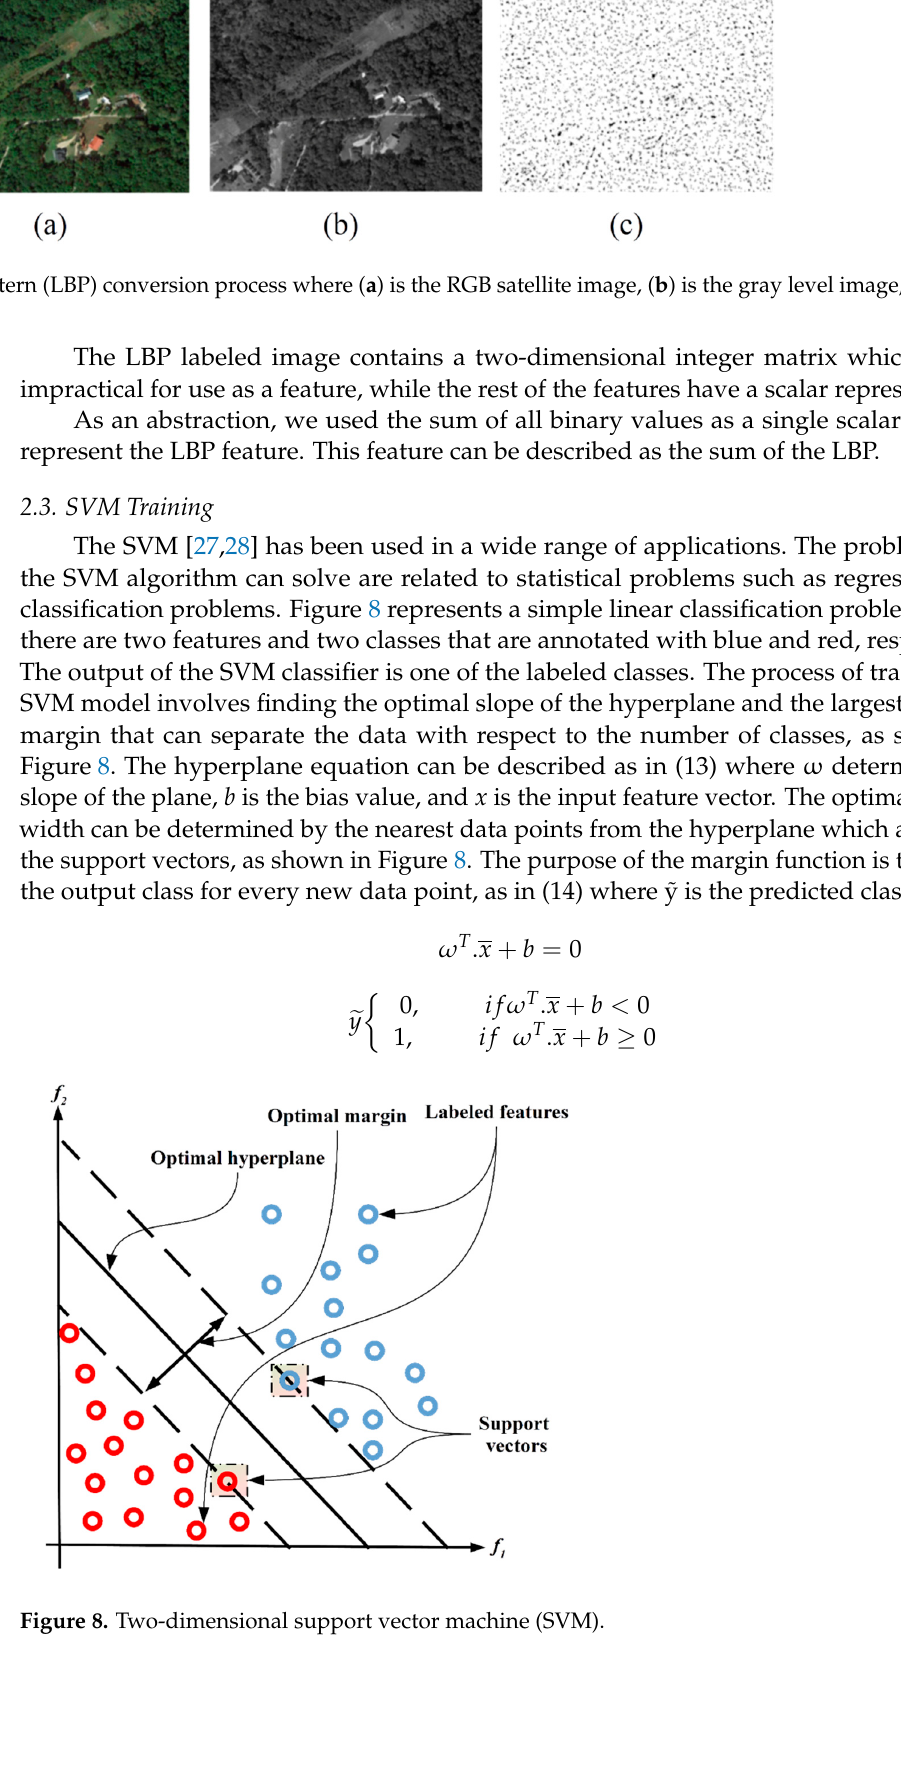
Figure 8. Two-dimensional support vector machine